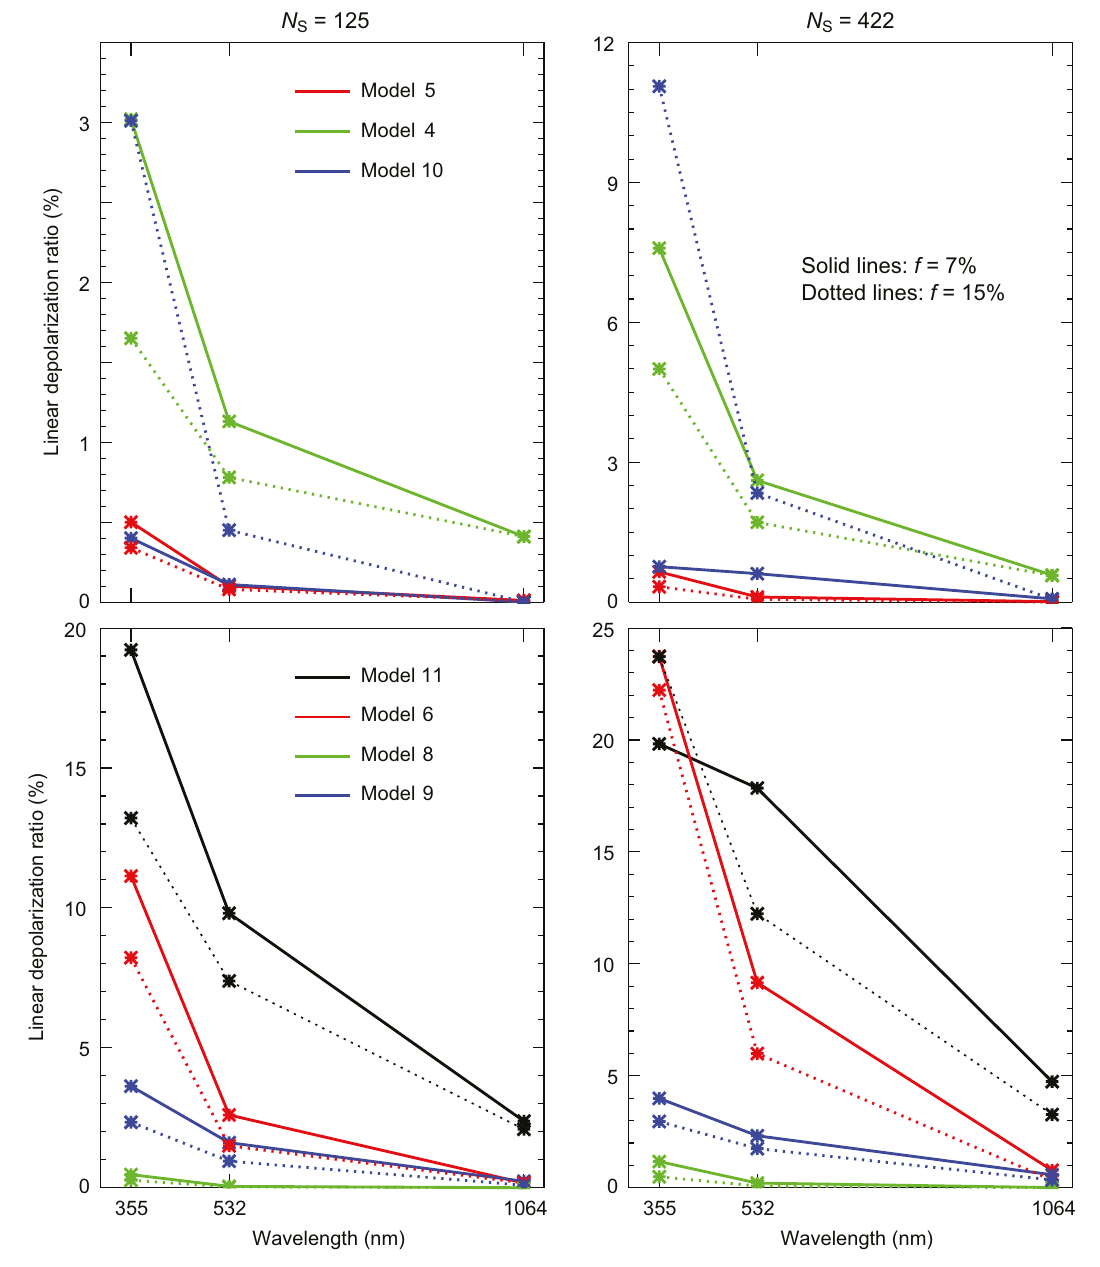
Figure 7. Linear depolarization ratios at the three HSRL-2 wavelengths for different morphological models. The solid and dotted lines depict the results for soot volume fractions f = 7% and 15%, respectively. The number of soot spherules is N S = 125 (left-hand panels) and 422 (right-hand panels).